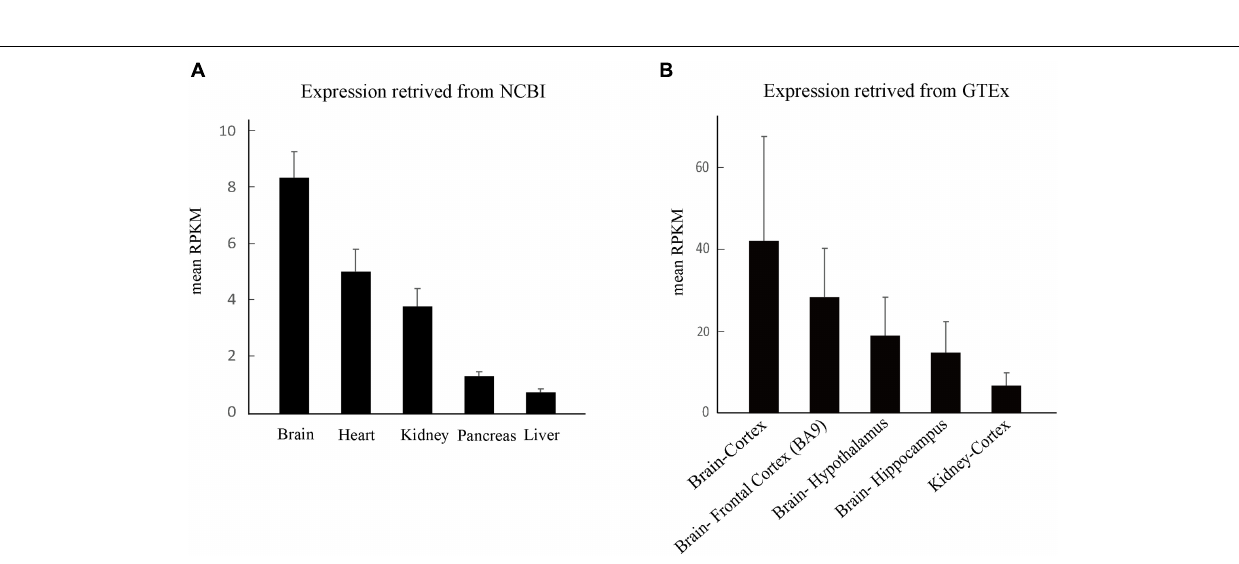
Frontiers in Molecular Neuroscience |